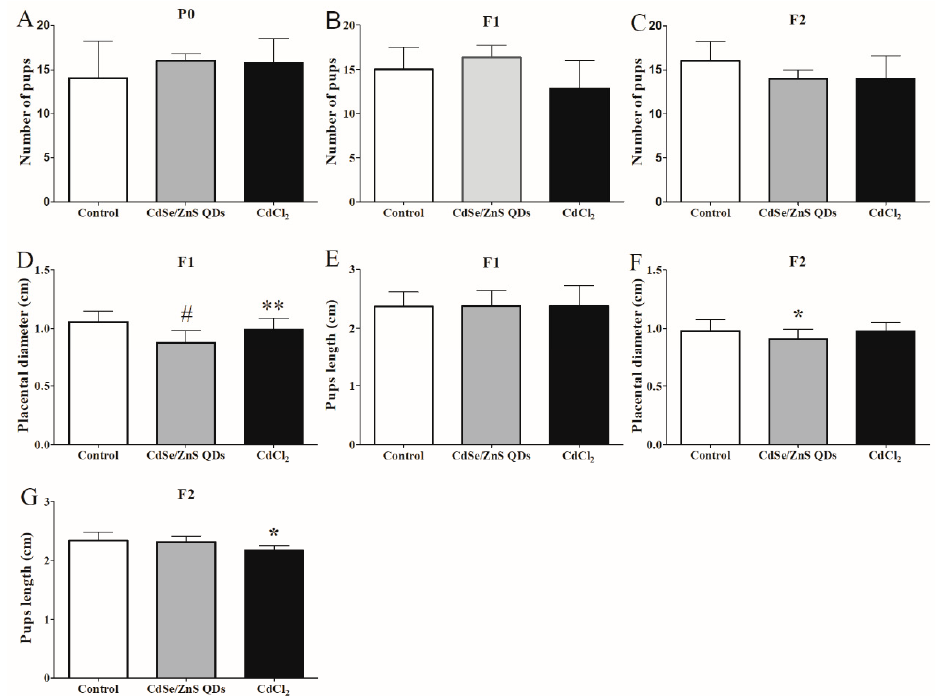
Figure 6. Reproductive ability and development status of mice in three generation after P0 exposure to QDs and CdCl 2 . ( A ) Number of pups in P0; ( B ) number of pups in F1; and ( C ) number of pups in F2. F1, F2 placental diameter ( D , E ) and fetus length ( F , G ). All the data are expressed as mean ± SD (n = 5). * p < 0.05, ** p < 0.01, # p < 0.001 vs. control.